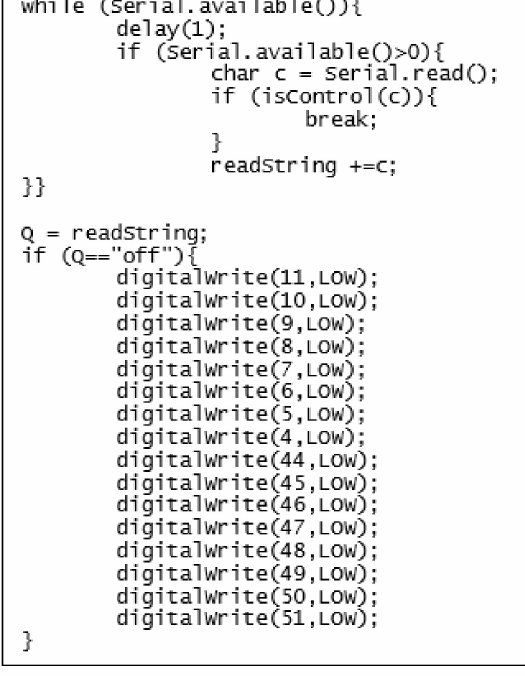
Figure 12. Arduino micro-controller sample serial communication